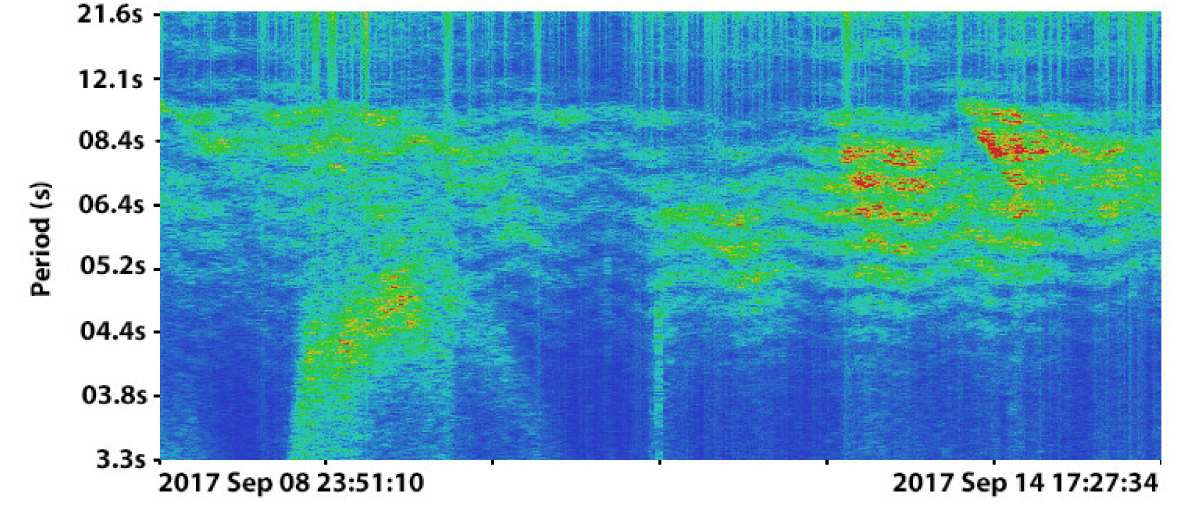
Figure 6. Dynamic spectrogram of a record of laser meter of hydrosphere pressure variations.